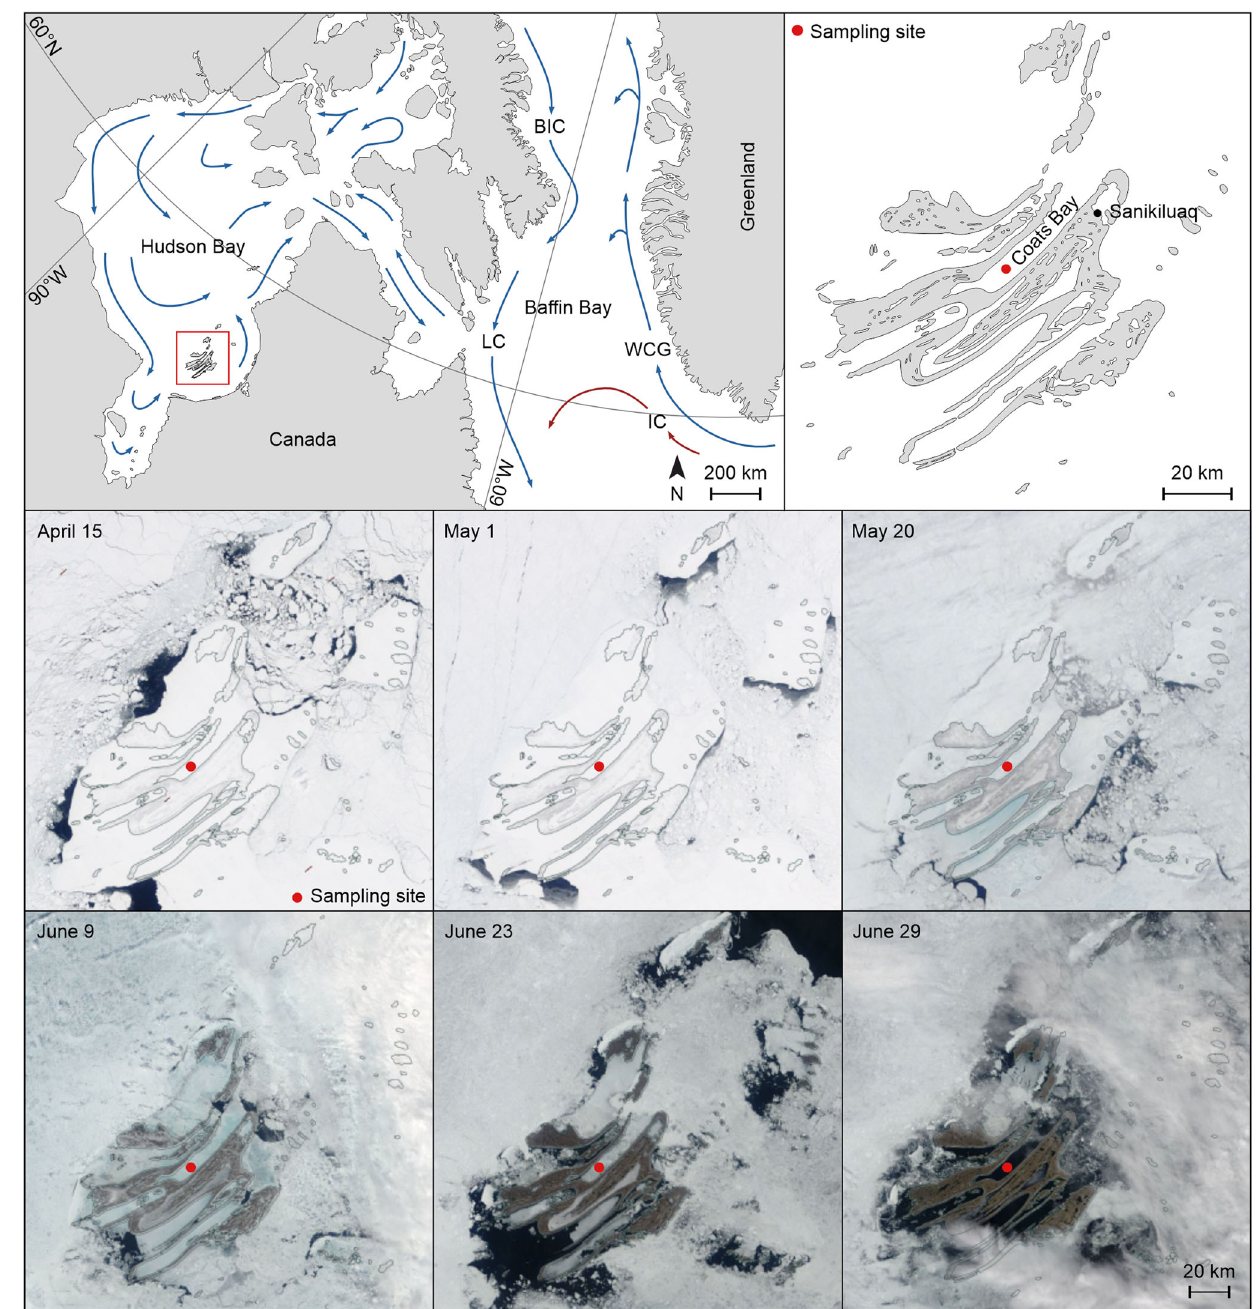
Fig. 1 Map of the study area. Map of the study area showing the anti-cyclonic currents in Hudson Bay as well as major cold (blue) and warm (red) currents in the area; BIC Baf fi n Island Current, LC Labrador Current, WGC West Greenland Current and IC Irminger Current. The sampling location is marked with a red dot. Satellite images (NASA Worldview) show the sea-ice extent over the study